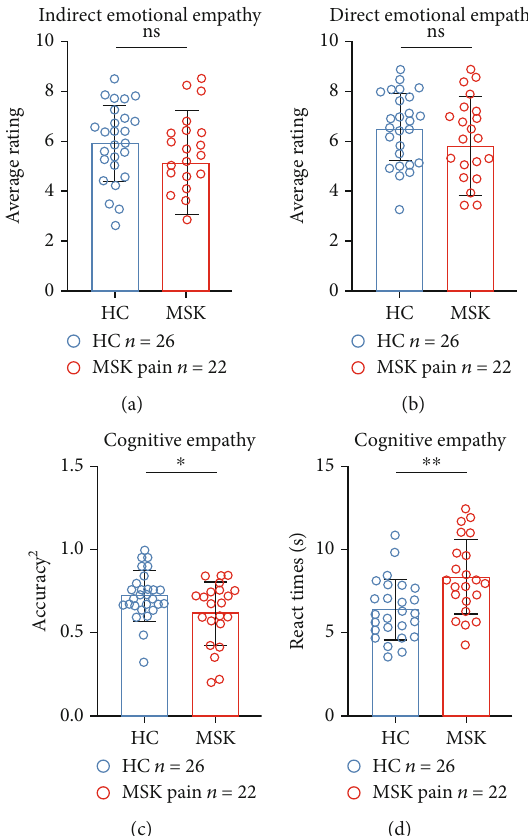
Figure 3: Comparisons of the indirect emotional empathy score (a), direct emotional empathy score (b), squared cognitive empathy accuracy (c), and task completion time for cognitive empathy section (d) between chronic musculoskeletal pain (MSK pain) and healthy control (HC) groups. ns: no signi fi cant; ∗ P < 0 : 05 ; ∗∗ P < 0 : 01